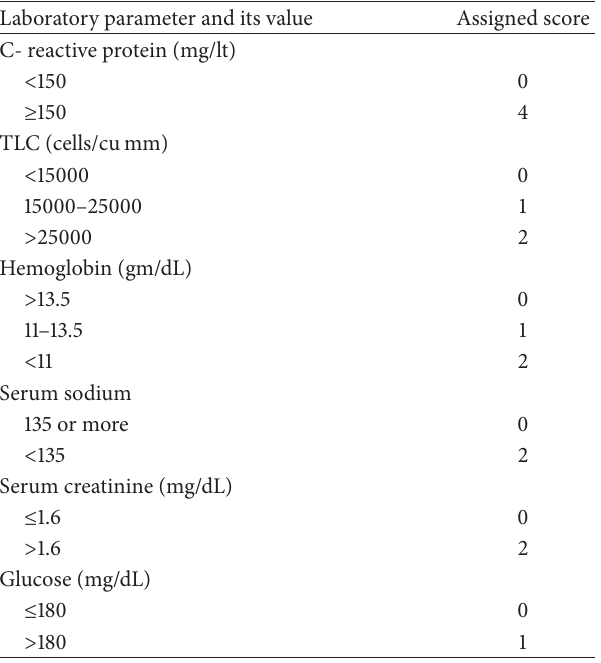
Table 1: Laboratory risk indicator for necrotizing fasciitis score— LRINEC [55].